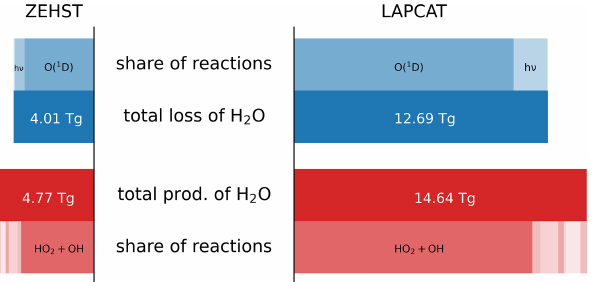
Figure 7. Bar plot of annual chemical loss and production perturba- tion of H 2 O at stratospheric altitudes (100–0.1hPa) for the ZEHST (left) and the LAPCAT (right) scenarios due to emitted trace gases (scenario–reference). This diagnosis includes a total of five H 2 O- destroying and 45 H 2 O-producing chemical reactions. The most relevant reactions of loss and production are shown as bright red and blue bars. Additionally, all dominant reactions of production are presented in detail in Fig.